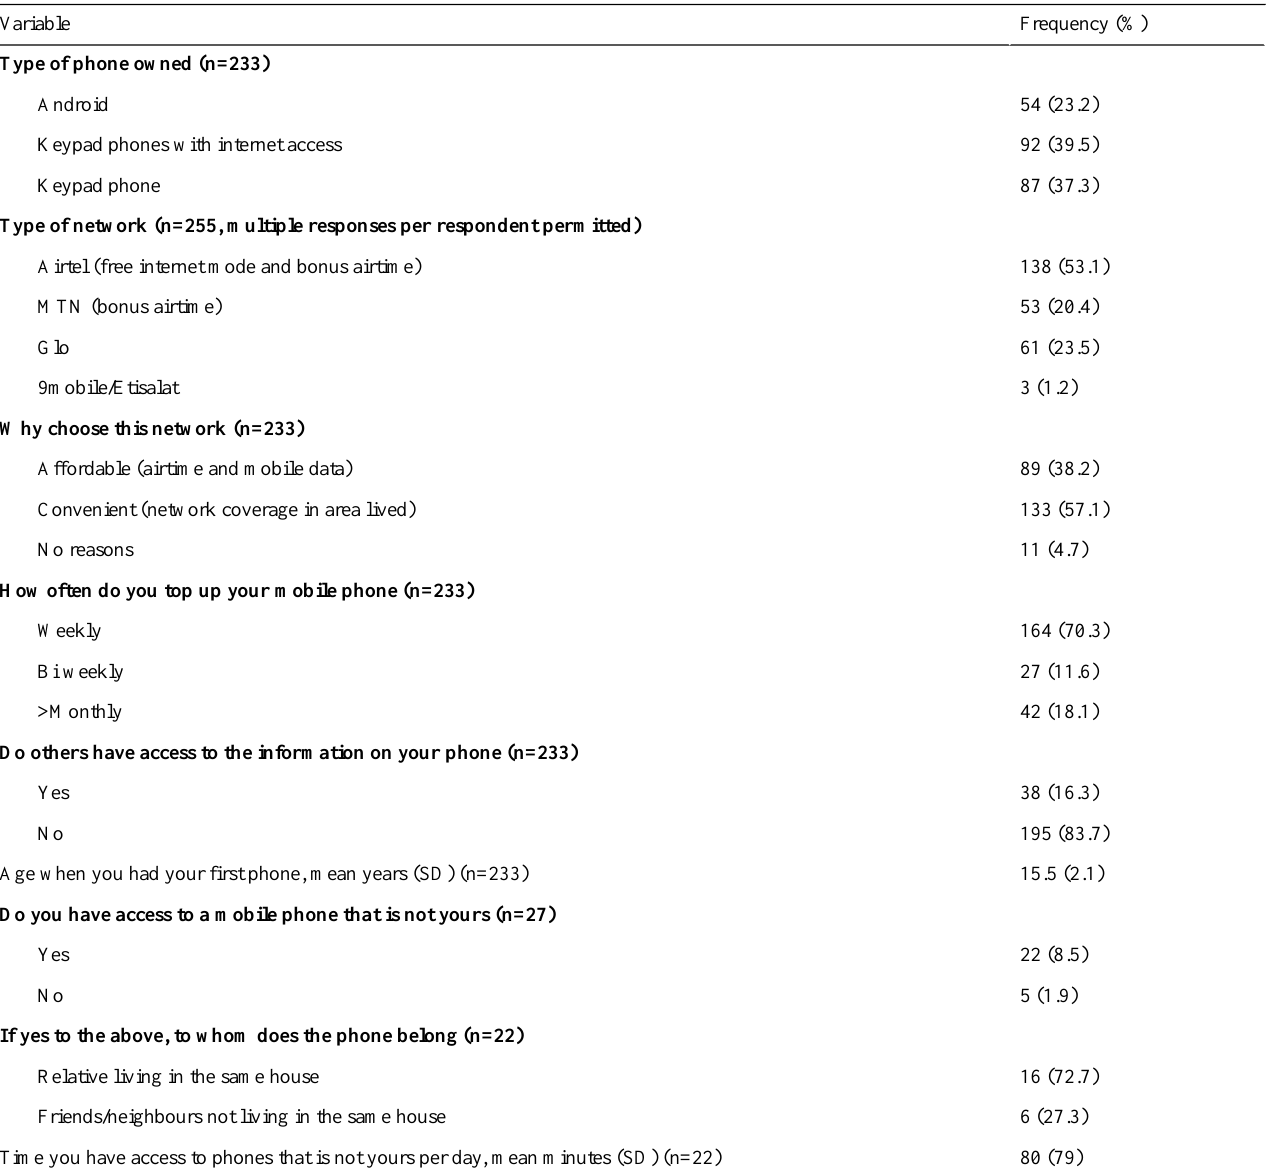
Table 1. Mobile phone ownership, privacy, and access among respondents